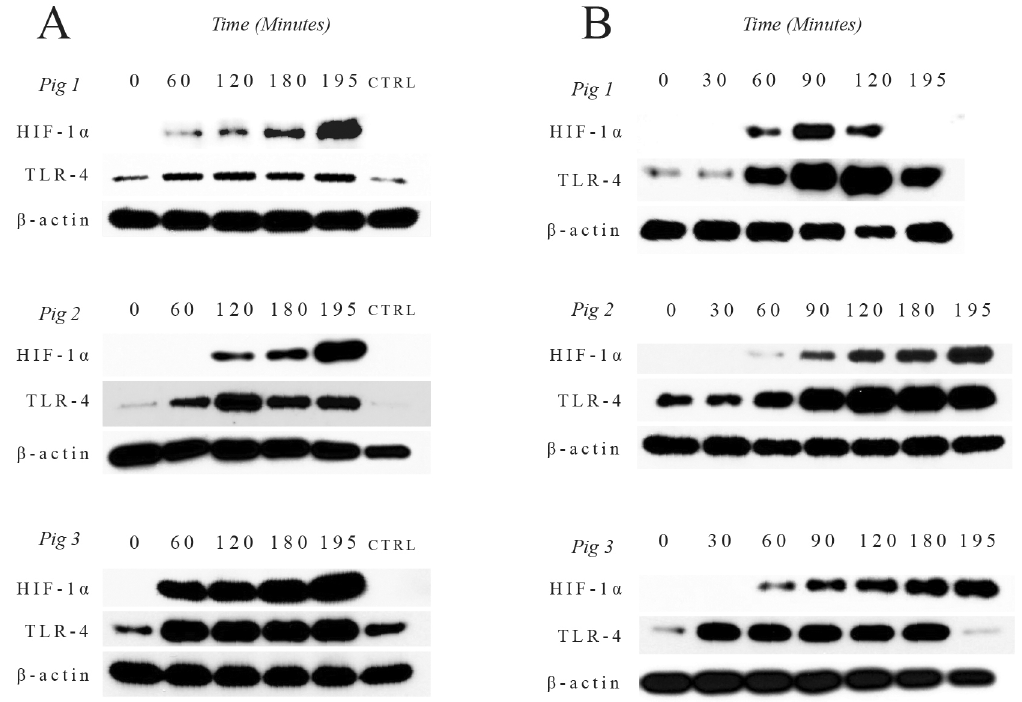
Fig 1. Western blots of hypoxia inducible factor-1 α (HIF-1 α ) and toll like receptor 4 (TLR4) expression in kidney tissue (A) and peripheral blood leukocytes (B). CTRL = control. Beta-actin ( β -actin) was used as a loading